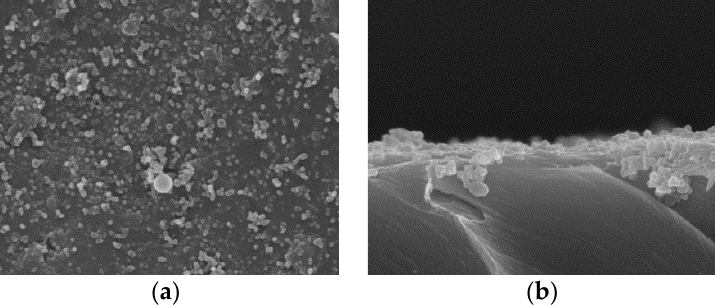
Figure 5. Apatite formation on PPBES via pHAF. ( a ) Top-down SEM image; ( b ). Cross-sectional SEM image.